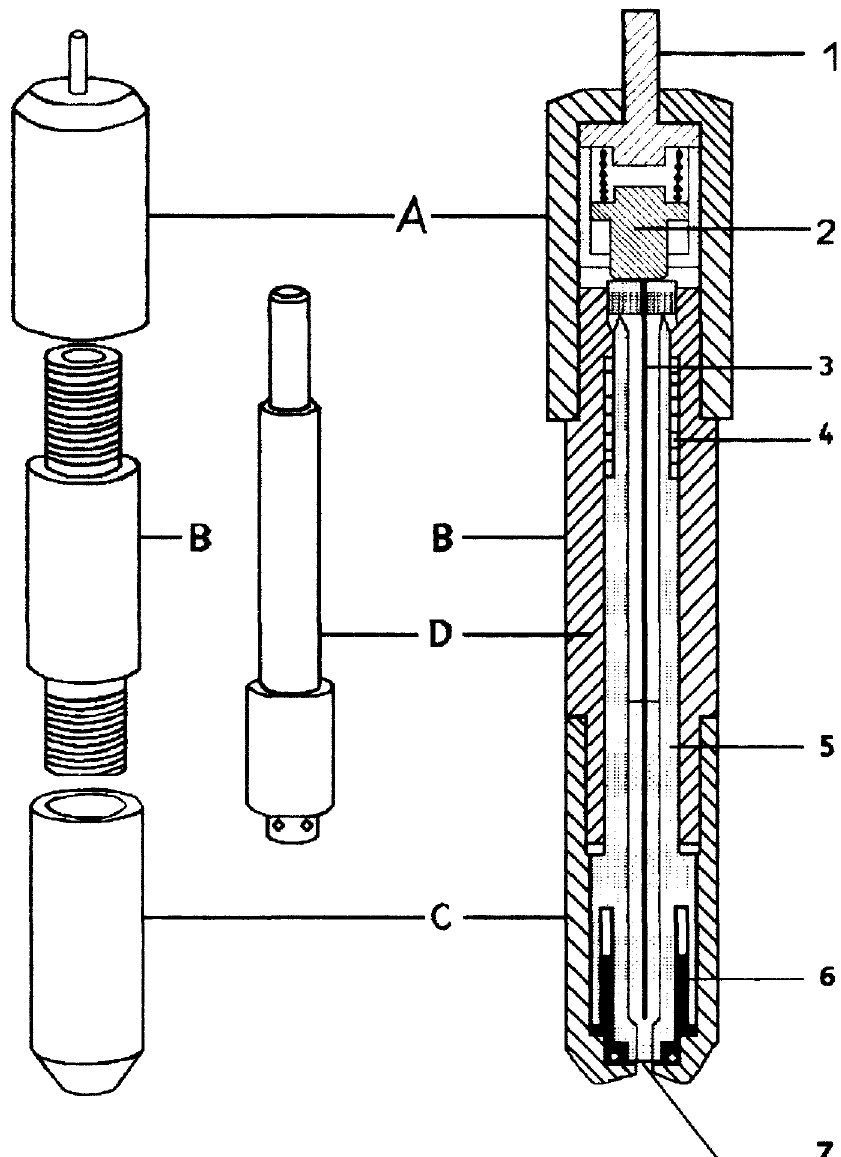
Fig. 1 The electrode